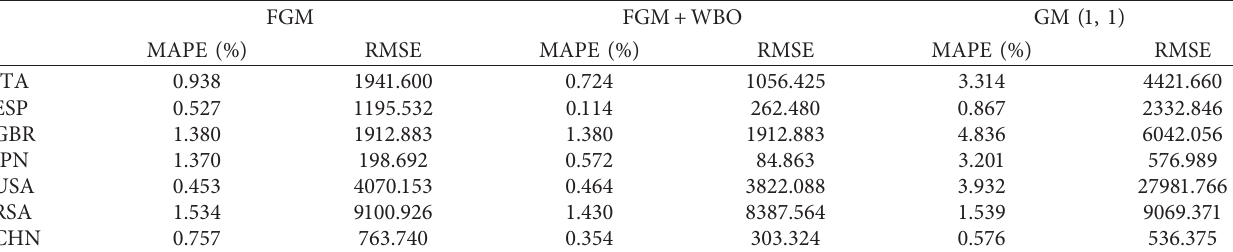
Table 4: The prediction